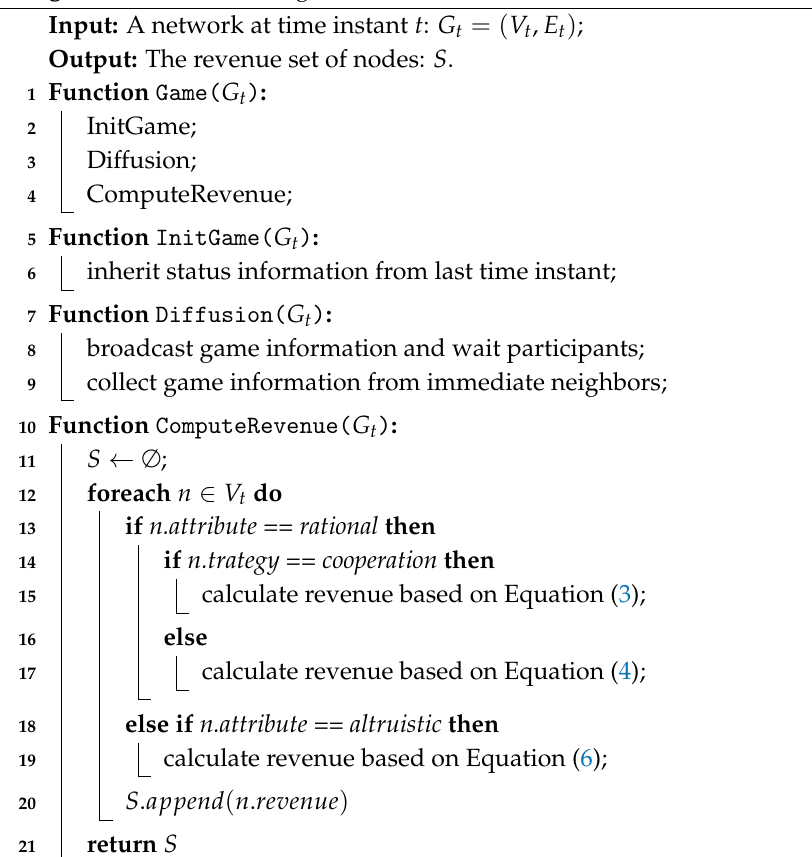
Algorithm 1: DAPGG